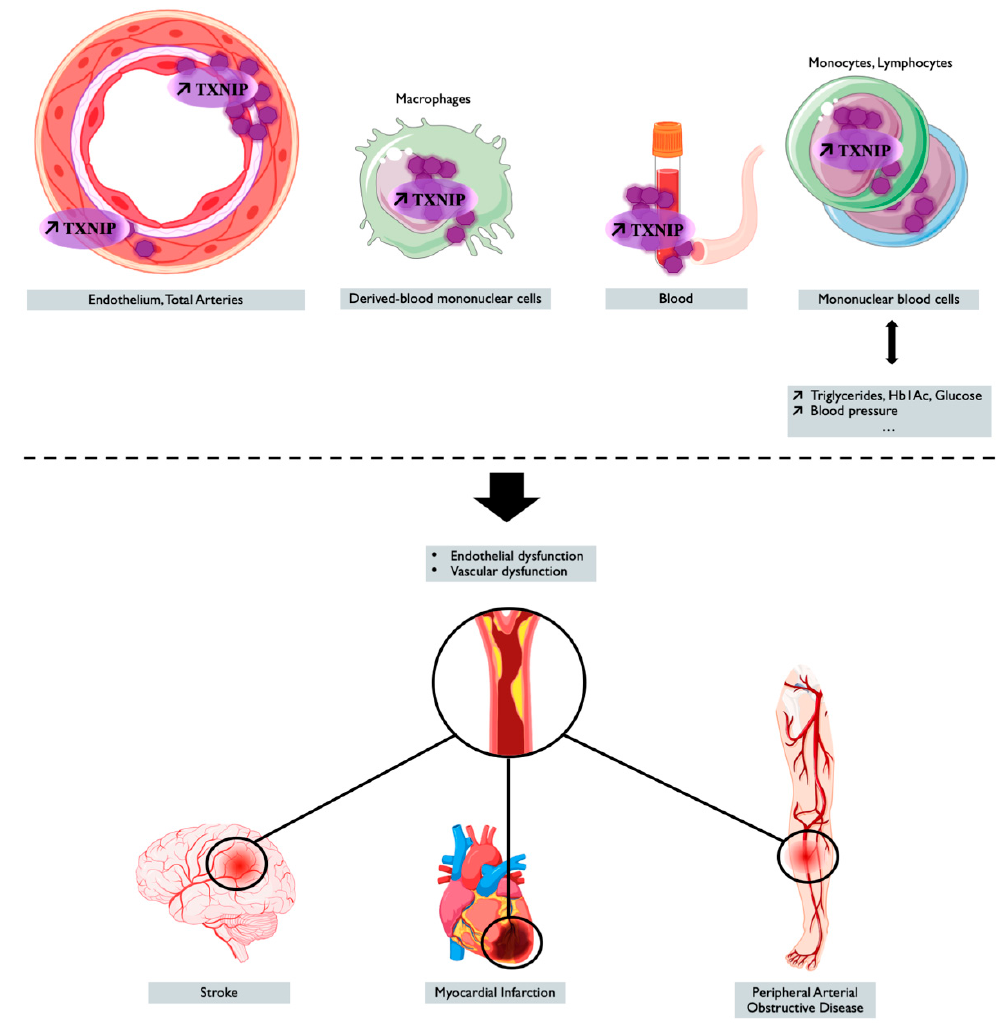
Figure 2. TXNIP overexpression is associated with cardiovascular outcomes and diseases. Tissue, blood levels of TXNIP, and the genetic regulation of TXNIP make it a potential marker associated with cardiovascular risk factors or cardiovascular event or diseases. Created with BioRender.com.